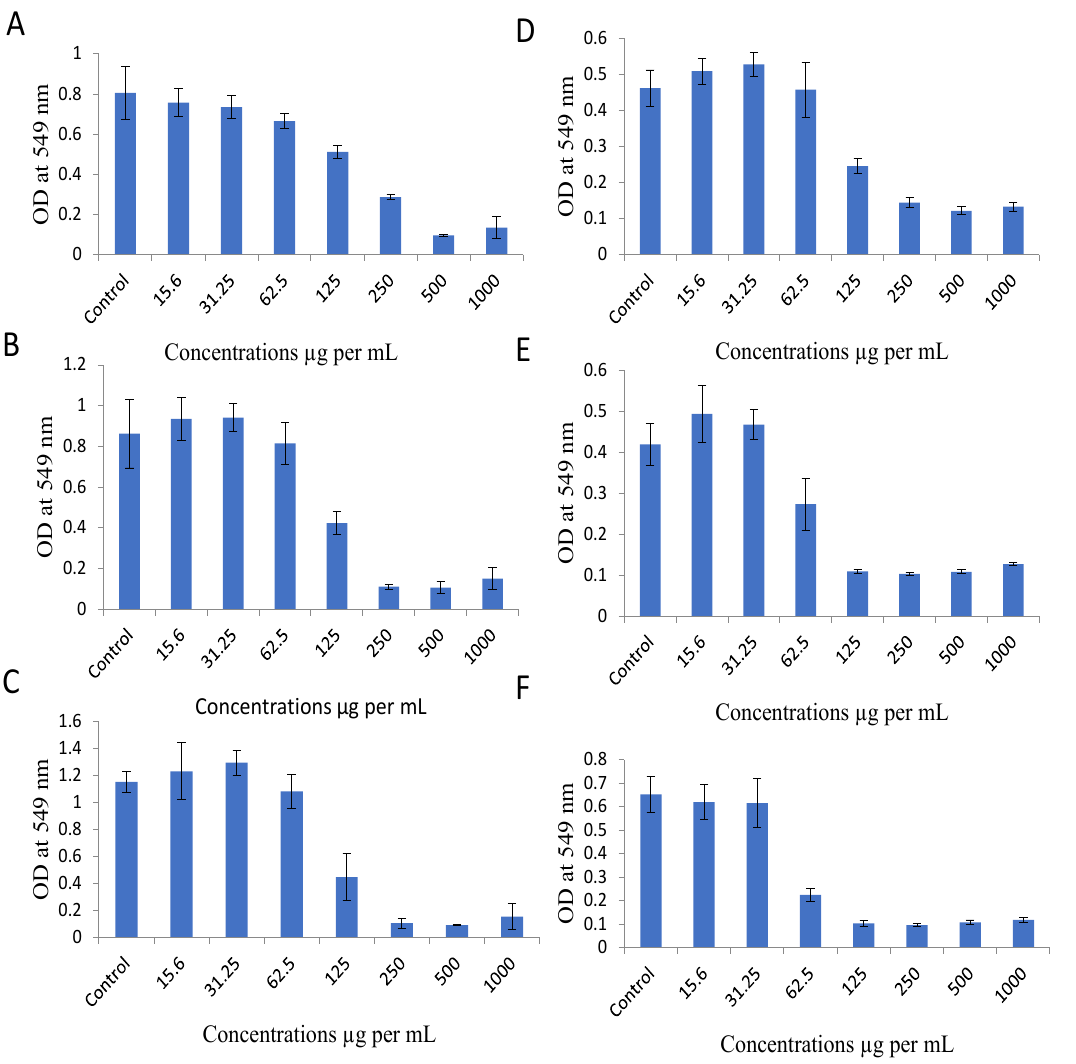
Figure 1. Dose- and time-dependent anti-proliferation activity of the ethanolic extract of C. calcitrapa (EECC). EECC inhibits proliferation of two breast cancer cells, MCF-7 (( A ), for 24 h; ( B ), for 48 h; ( C ), for 72 h) and MDA 231 (( D ), for 24 h; ( E ), for 48 h; ( F ), for 72 h). Cancer cells were treated with the indicated concentrations of EECC with DMSO control for 24, 48 and 72 h followed by determination of proliferation by MTT assay, as detailed in the Methods part. Data represent mean ± SD of 8 technical well-replicates.